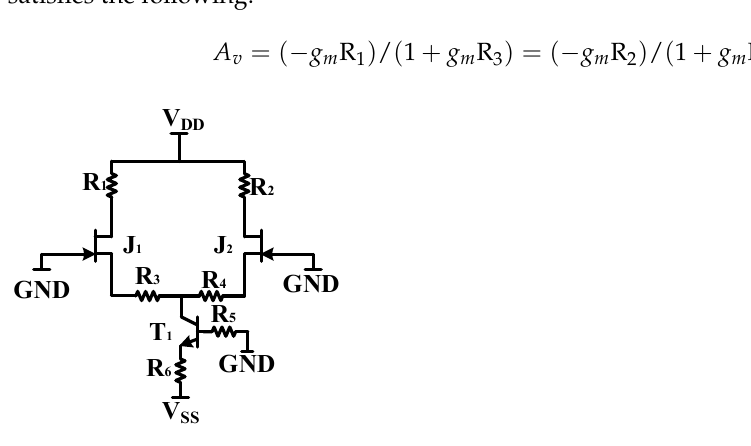
Figure 6. DC equivalent path of JFET differential circuit.